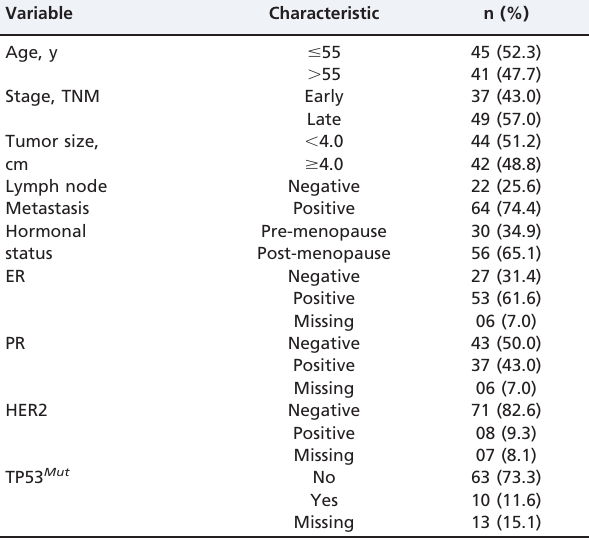
Table 1 - Patient and tumor characteristics (n = 86).